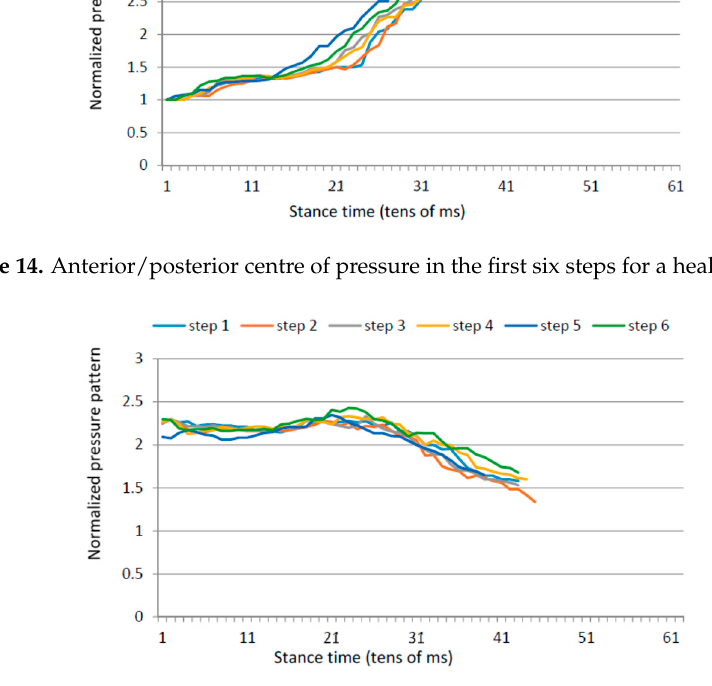
Figure 15. Lateral centre of pressure in the first six steps for a healthy control.